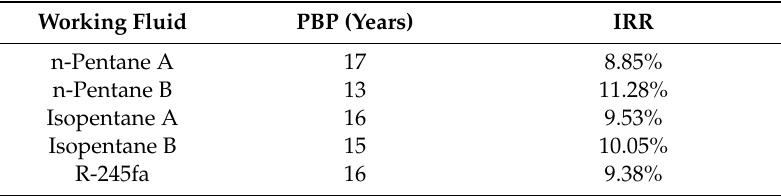
Table 8. Project Payback Period and Internal Rate of Return results.